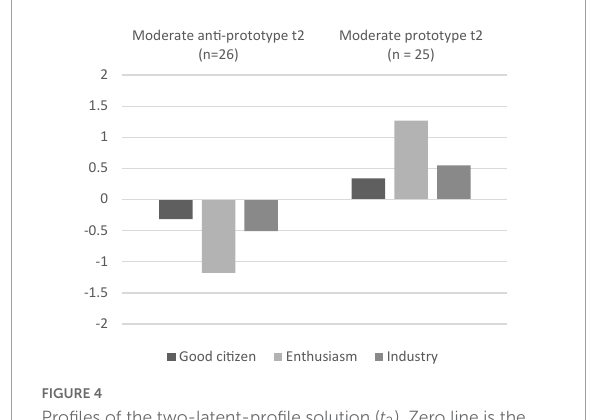
two followers would have participated if participation had been equally distributed across all profiles) and these followers had the significantly lowest levels of personal initiative, which may be an additional reason. About 76.47% of the followers remained in their previous profile. Twelve followers changed their profile (five from Moderate Anti-Prototype to Moderate Prototype and seven vice